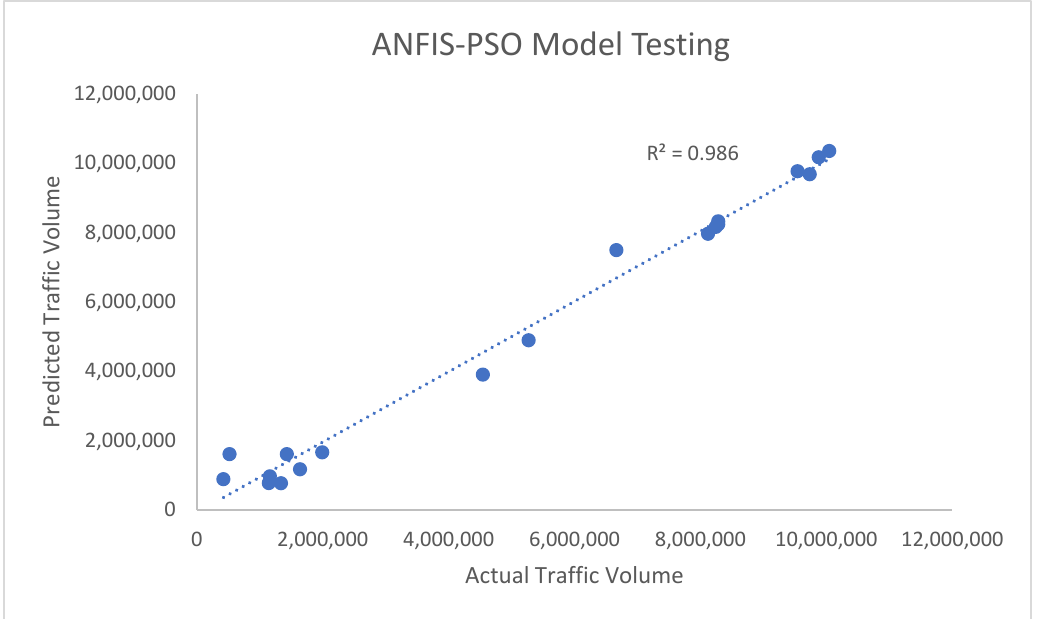
Figure 8. Comparison between the Actual South Africa Traffic volume versus the ANFIS-PSO Pre- dicted traffic volume (Testing).